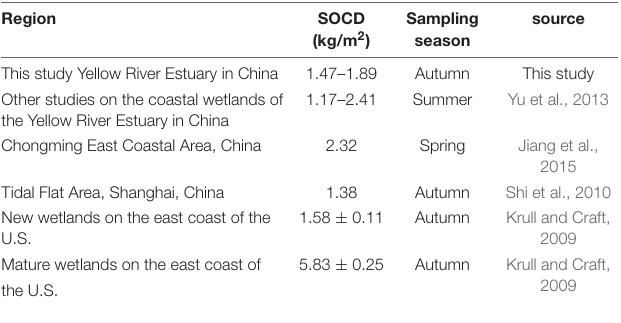
TABLE 2 | Organic carbon density and sampling time of different coastal wetlands.